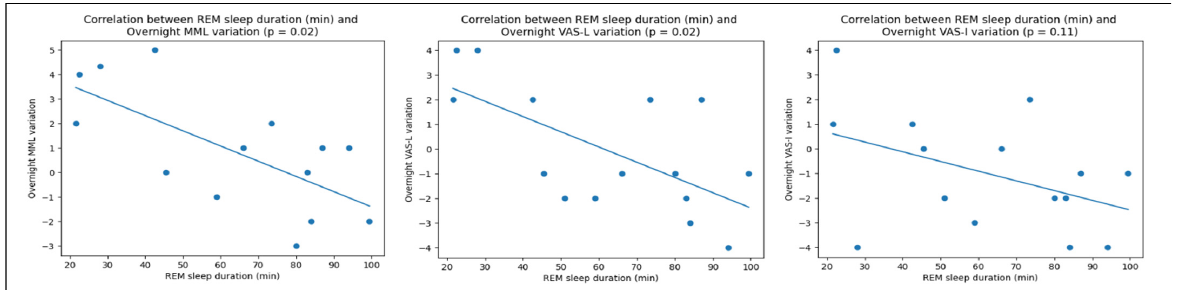
Figure 3. Anticorrelations between REM sleep duration (in min) and overnight tinnitus variations measured by Minimum Masking Level (MML), Visual Analog Scales on Tinnitus Loudness (VAS-L) and Intrusiveness